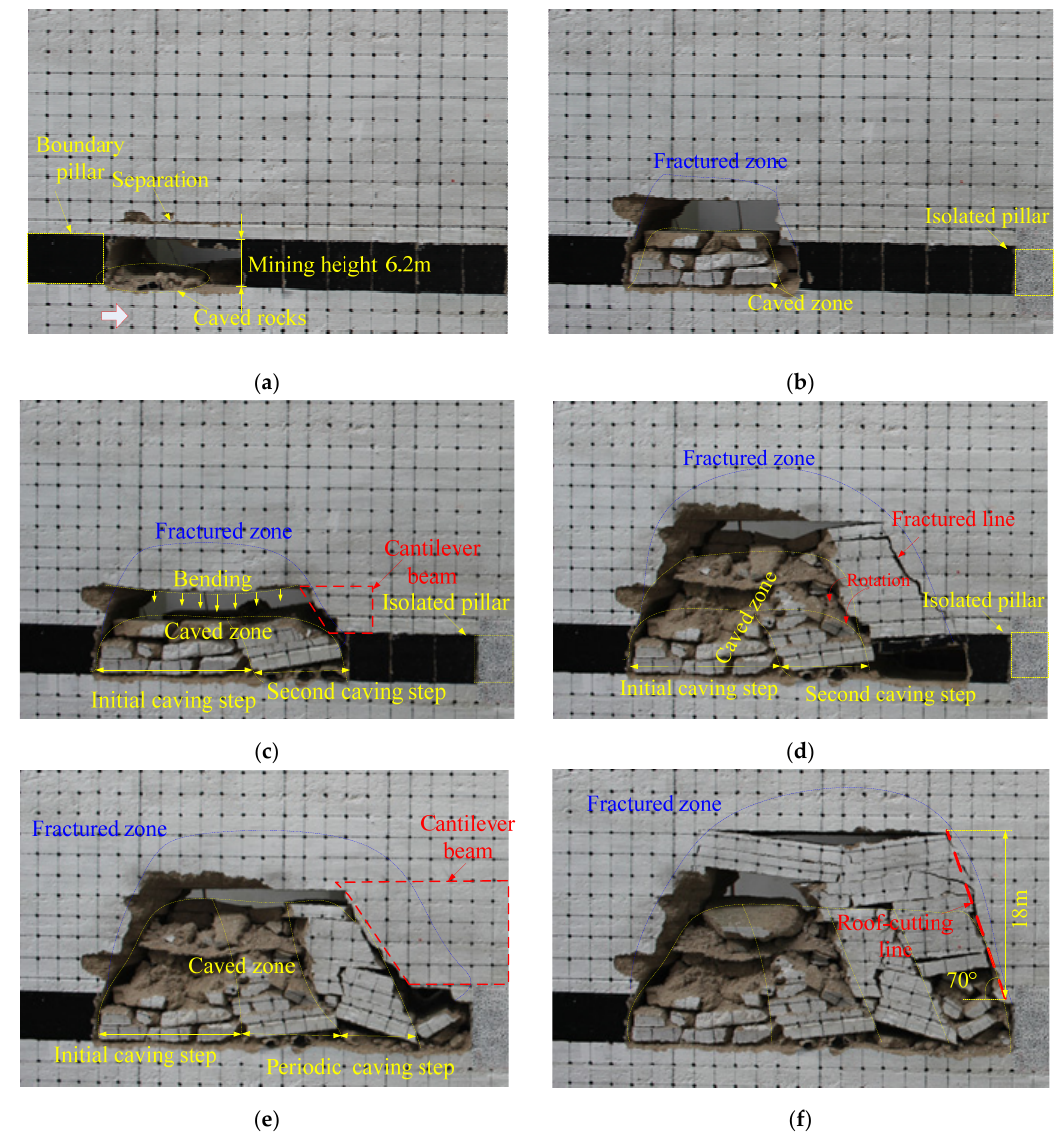
Figure 8. Overburden strata movement process during the excavation of the 2101 panel. ( a ) Advanced 21 m; ( b ) advanced 27 m; ( c ) advanced 45 m; ( d ) advanced 47 m; ( e ) advanced 70 m; ( f ) after roof-cutting.